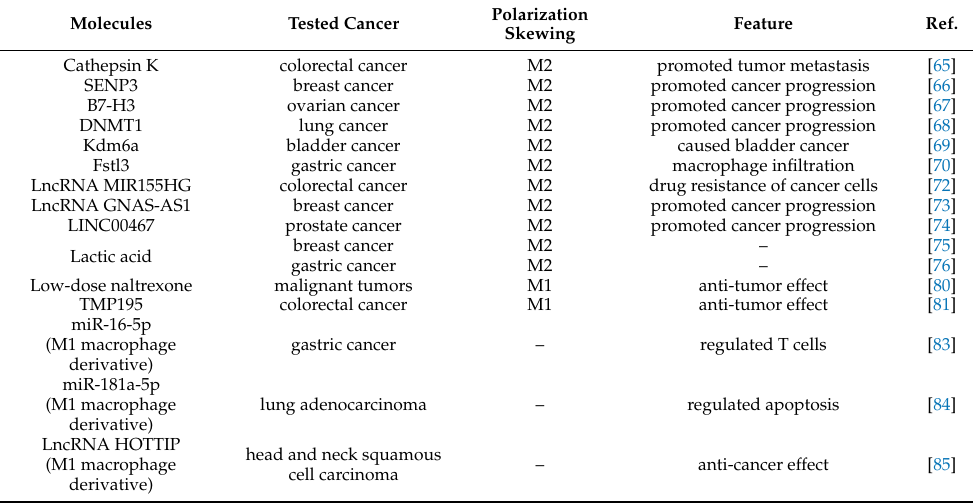
Table 1. Molecules involved in macrophage